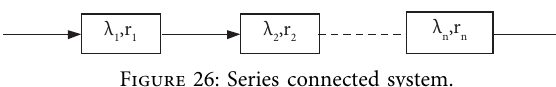
Figure 26: Series connected